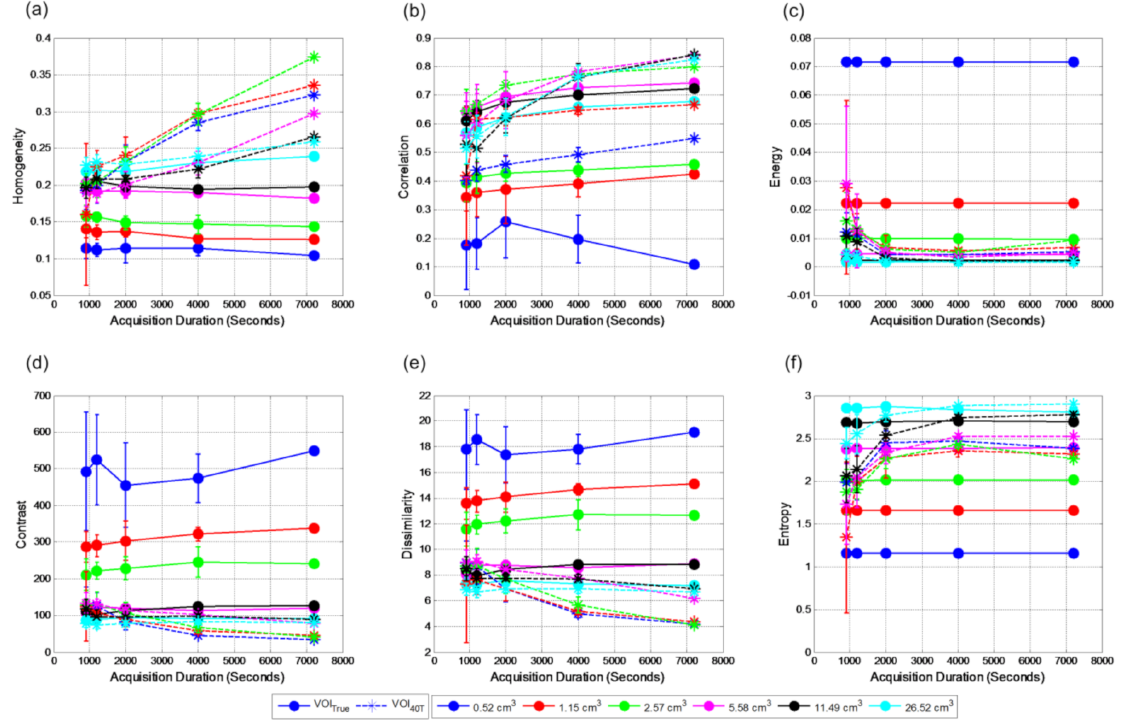
Figure 8. Six textural features vs. acquisition durations for two different segmented volumes (VOI true and VOI 40T ) for contrast 2:1 and quantization level 64. ( a ) Homogeneity, ( b ) contrast, ( c ) energy, ( d ) contrast, ( e ) dissimilarity and ( f ) entropy.